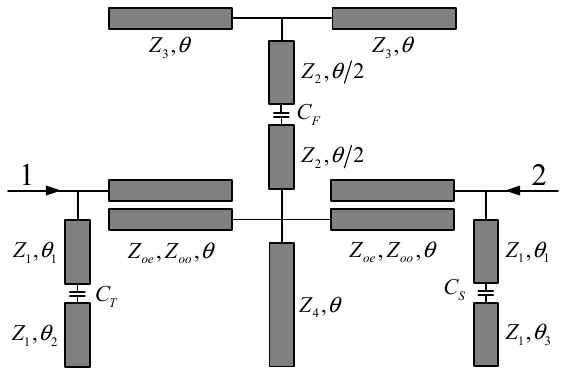
Figure 1. The novel topology for the proposed filters ( θ L = θ 1 + θ 2 , θ R = θ 1 + θ 3 ).